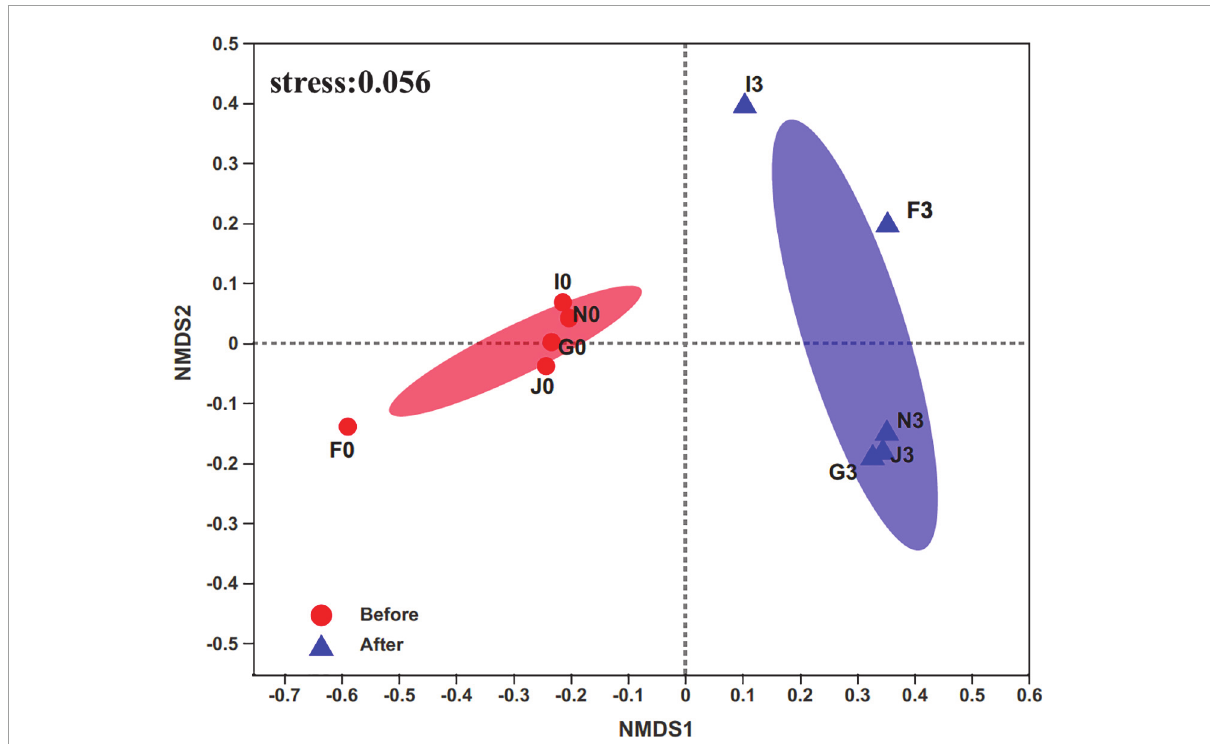
FIGURE1 Non-metric multidimensional scaling (NMDS) analysis on the OTU level compares bacterial communities’ clustering patterns in cultures before and after enrichments. F, J, I, N, and G represent five different cultures derived from five surface sediments. Number 0 represents cultures before enrichments; number 3 represents cultures after